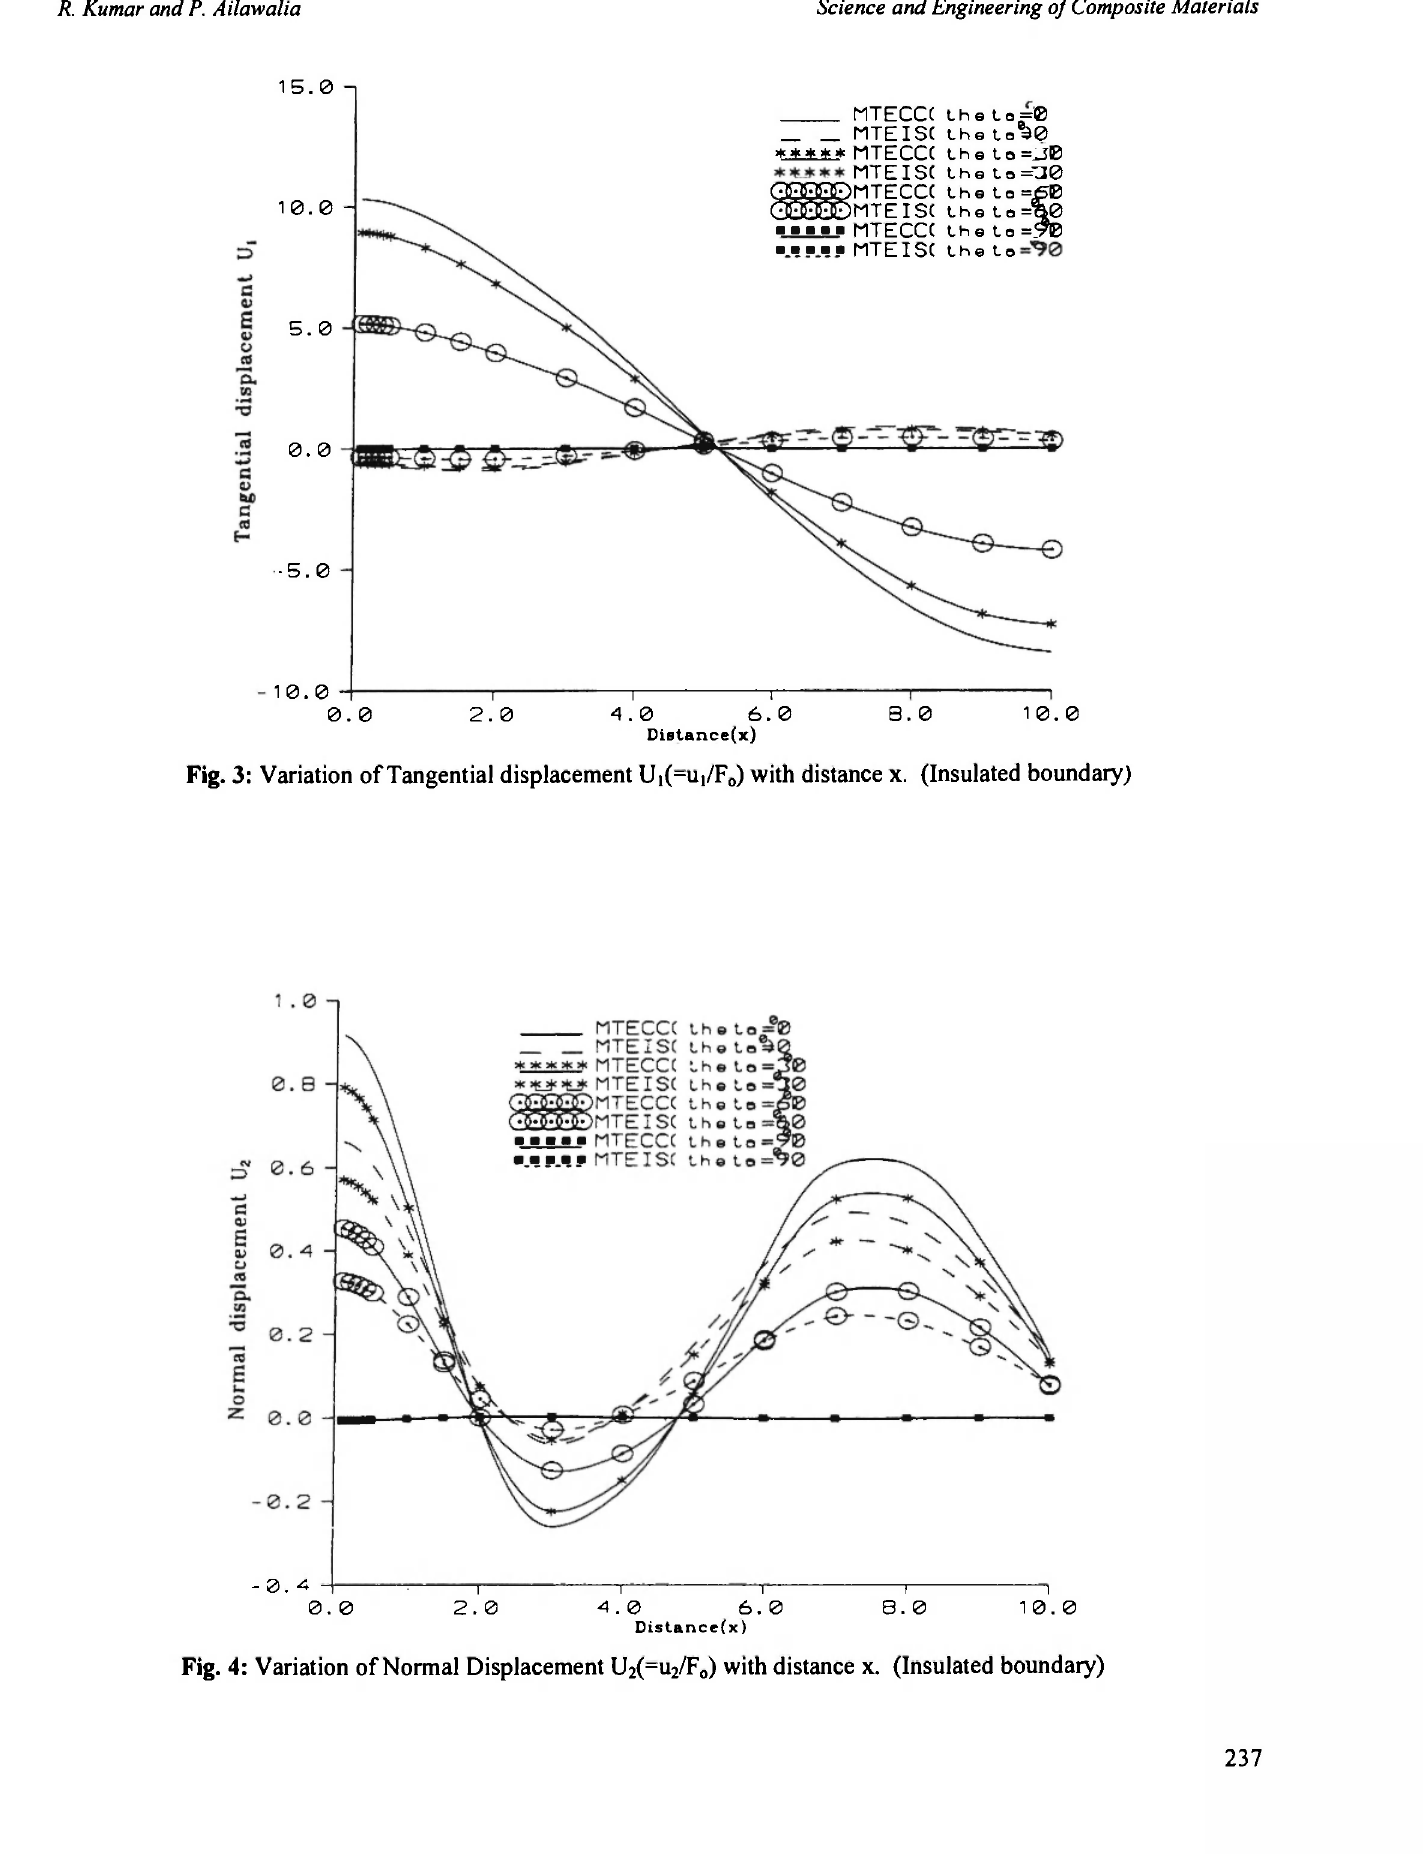
Fig. 4: Variation of Normal Displacement U 2 (=u 2 /F 0 ) with distance x. (Insulated